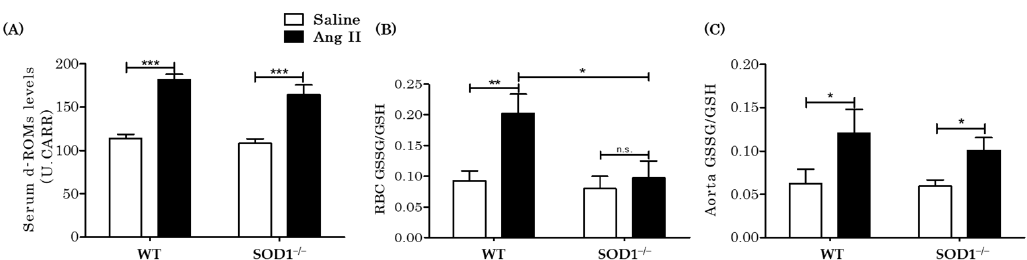
Figure 3. Extracellular and intracellular H 2 O 2 levels in blood and aortas in vivo. ( A ) Derivatives of reactive oxygen metabolites (d-ROMs), which detect hydro-peroxide (R–OOH), were measured as an extracellular H 2 O 2 indicator ( n = 12 per group. *** p < 0.001). ( B ) Oxidized glutathione (GSSG)/reduced glutathione (GSH) ratios were measured in RBCs as an indicator of intracellular H 2 O 2 ( n = 8 per group. * p < 0.05 ** p < 0.01 n.s.: not significant). ( C ) GSSG/GSH ratios in aortas ( n = 10~11 per group. * p < 0.05). Error bars represent SEM. ROS: reactive oxygen species; WT: wild type; SOD1 − / − :